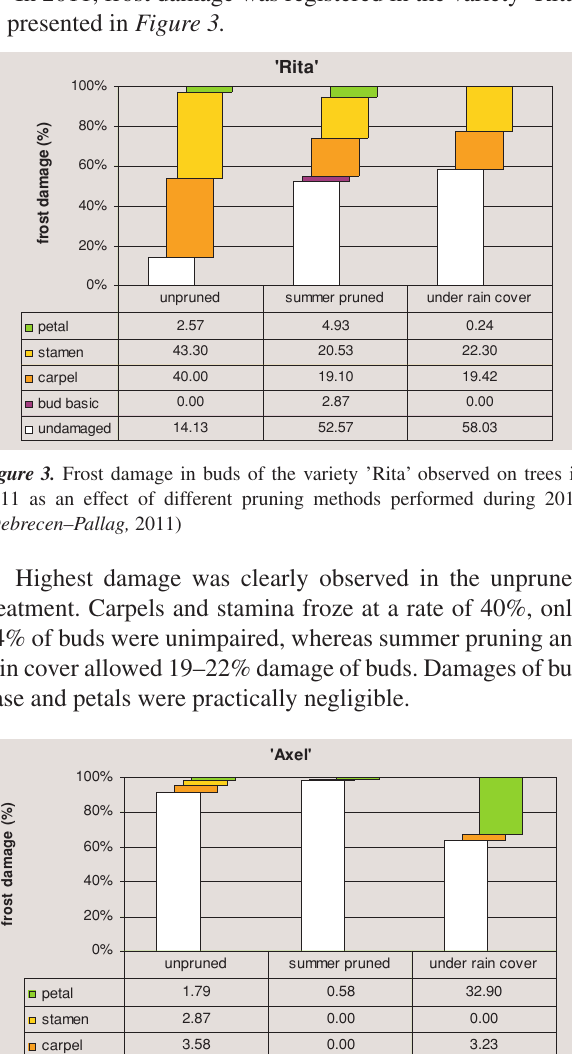
as an effect of different pruning and treatments performed during 2010